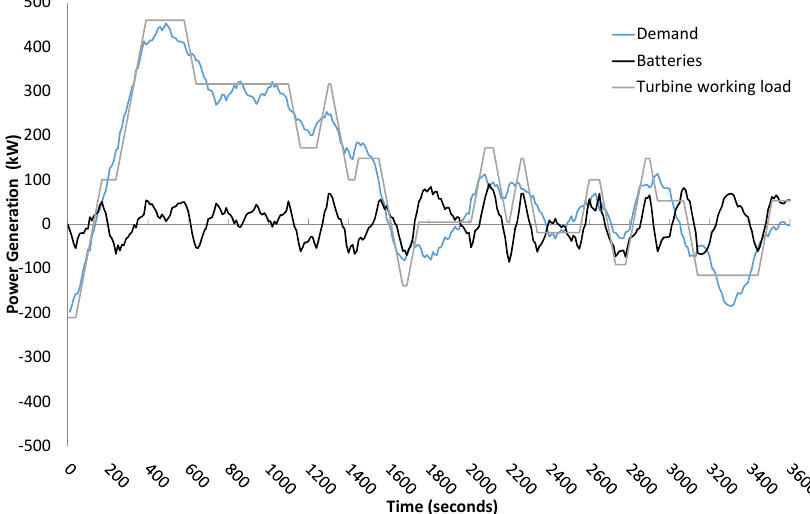
Figure 2. Working load of turbines and batteries in contrast to demand for the second scenario.